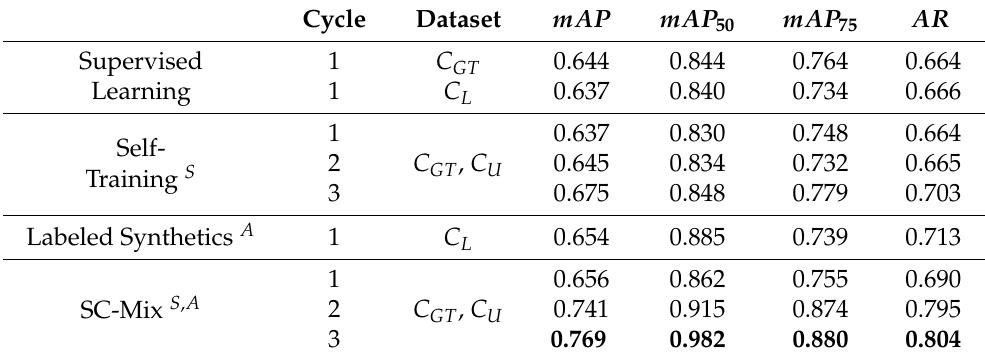
Table 1. Crop segmentation performance of the vertical farm dataset. The superior letter “ S ” denotes the use of the self-training scheme, and “ A ” indicates that the data augmentation process was employed via the proposed image synthesis